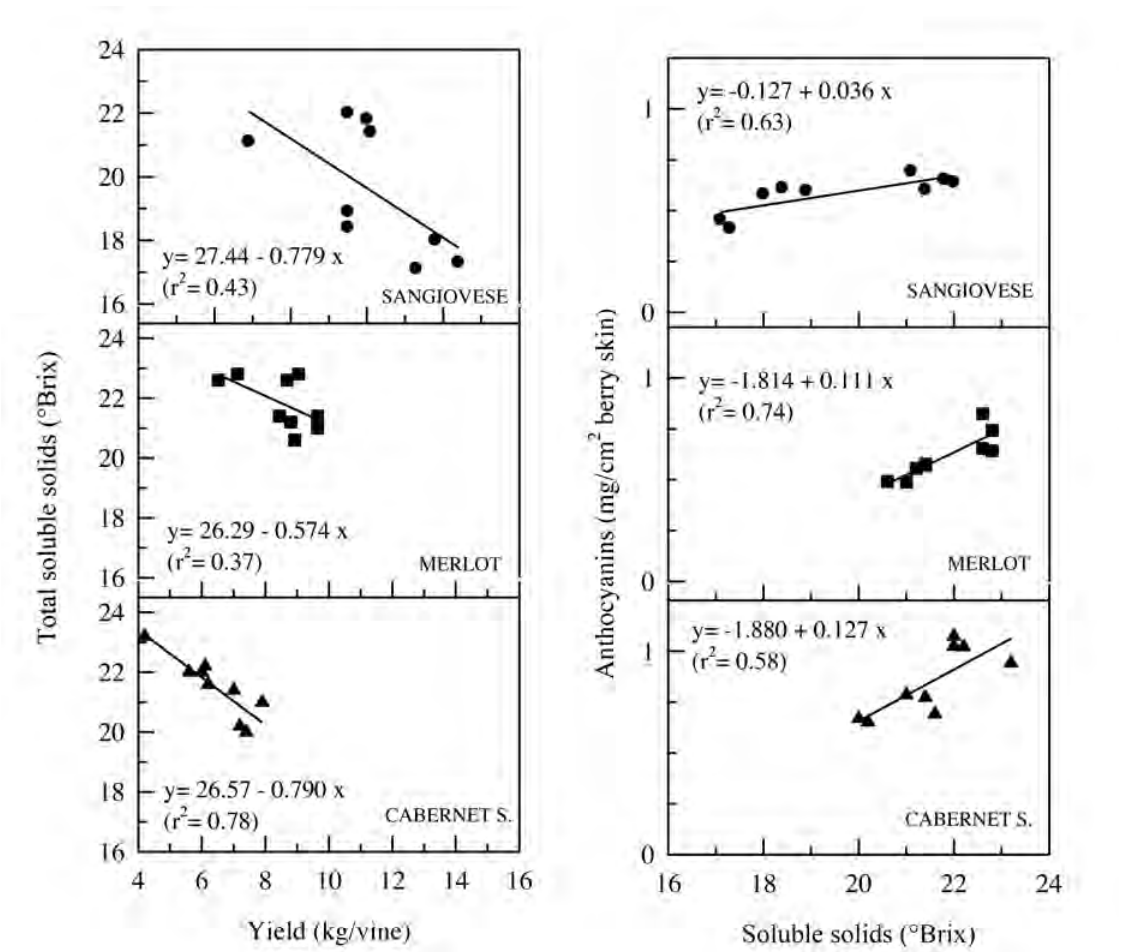
Fig. 4 - Relationship between yield per vine and total soluble solids (left) and total soluble solids and anthocyanins content in the berry skin at harvest